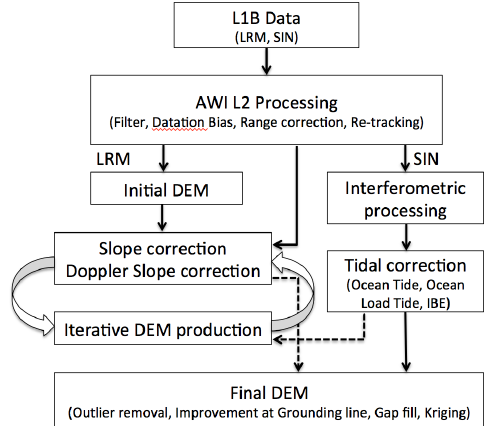
Figure 2. Diagram of the processing scheme used to derive the final DEM.